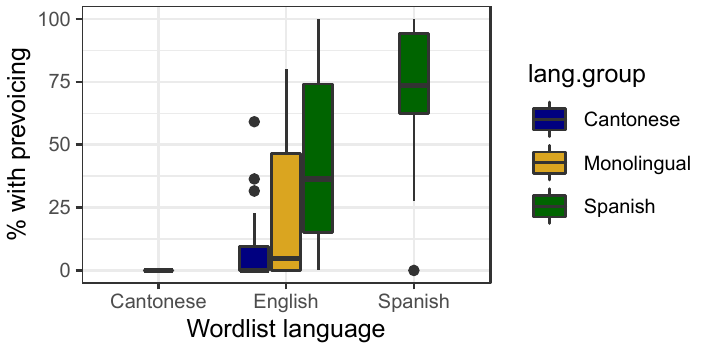
Figure 3. Percentage of phonologically voiced tokens produced with prevoicing in the baseline word reading task. Boxplots show distributions of by ‐ participant means.